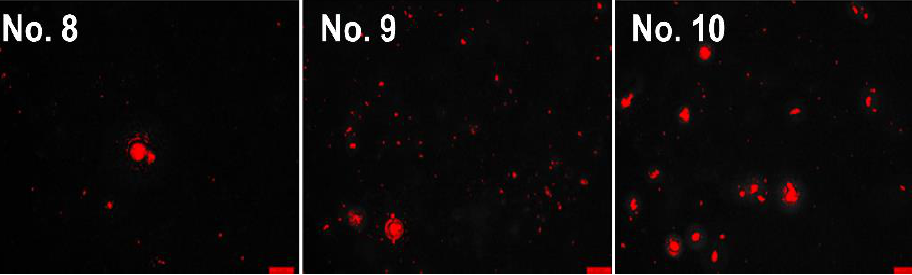
Figure 8. Images of the micro-organisms attached to specimens No. 8 – 10.